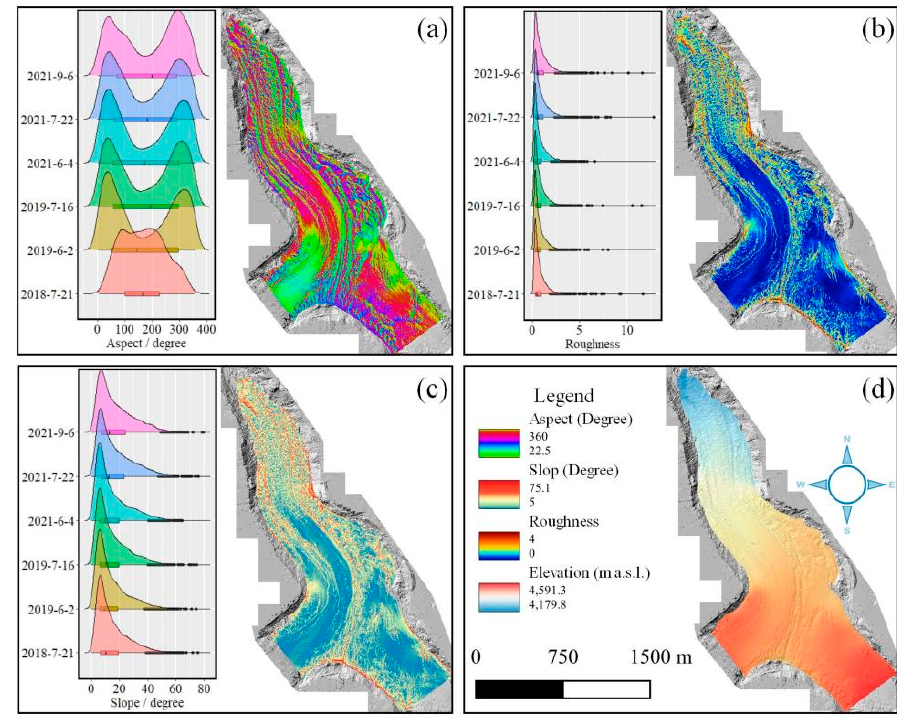
Figure 3. Terminus changes of LHG12. ( a ) Terminus changes in 1959–2021. The data source for the